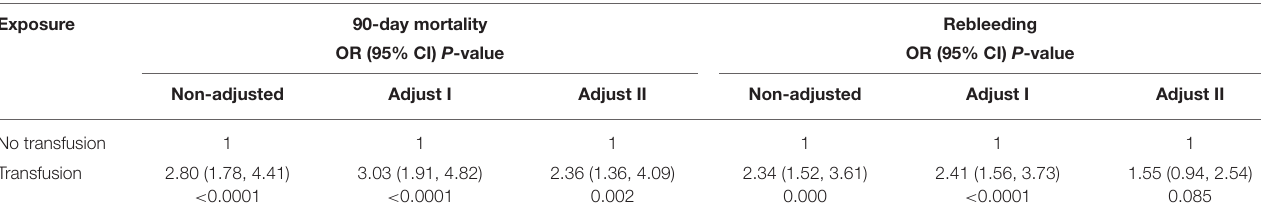
TABLE 3 | Association between FFP transfusion and 90-day mortality or rebleeding by multiple regression. Exposure